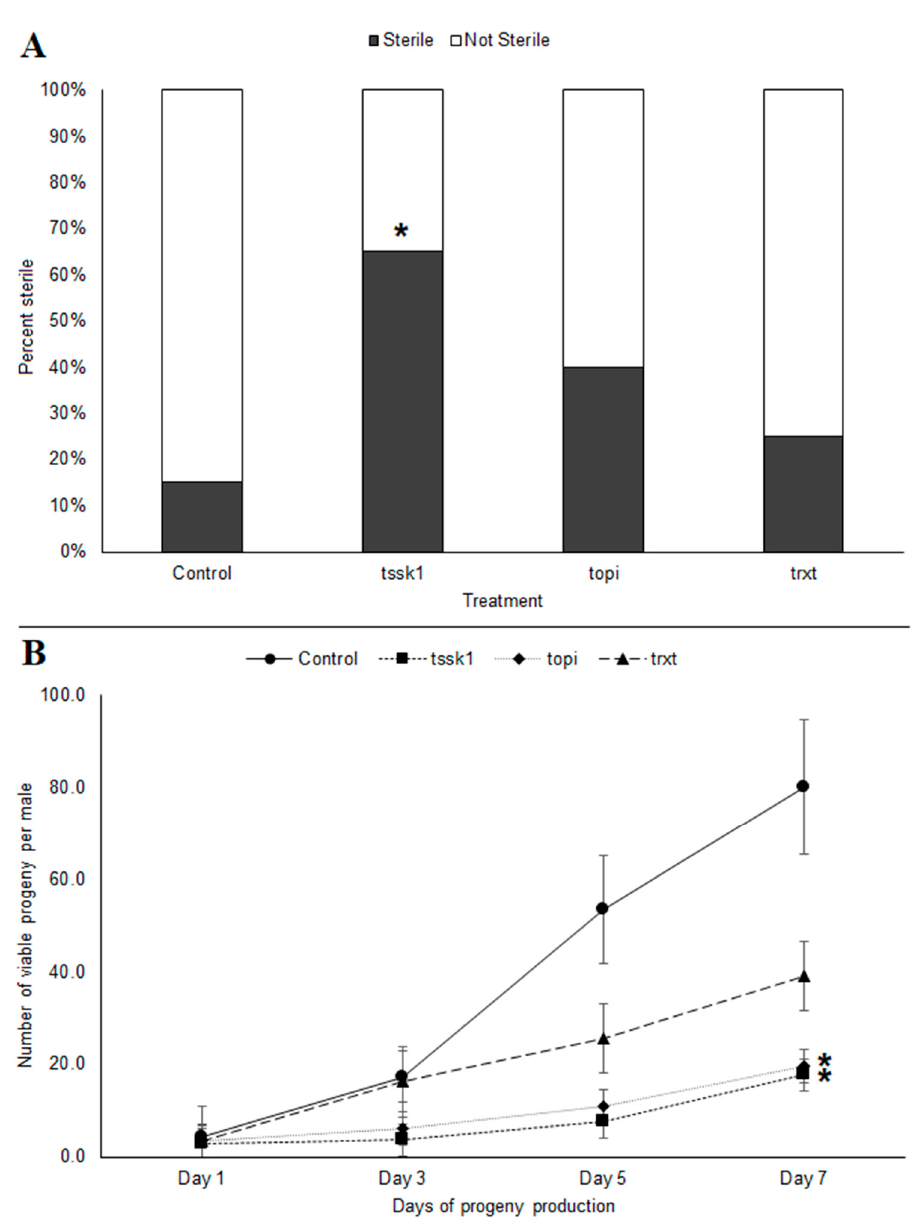
Figure 3. Reproductive fitness of tssk1 -, topi - and trxt -dsRNA treated males of Bactrocera tryoni over a 7-day period post-treatment: ( A ) Percentage of males exhibiting complete sterility; ( B ) Fecundity of dsRNA-treated males, based on number of viable progeny produced over a one-week period. Values represent the means (markers) and the 96% standard errors (whiskers) of 20 biological replicates; asterisks indicate significant differences ( p < 0.05).